Question: Summarize what this figure shows in one sentence.
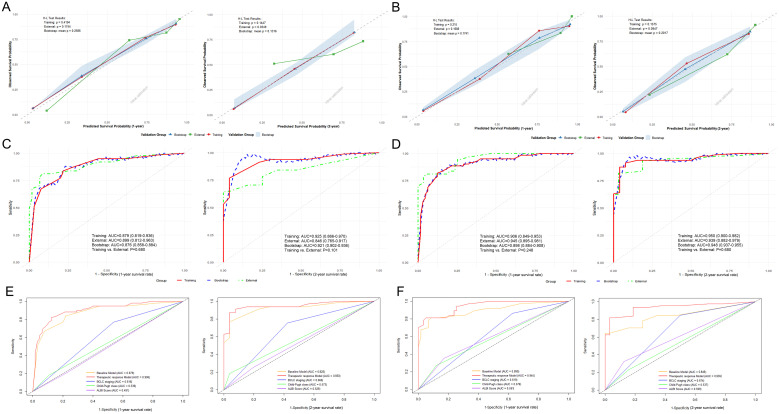
Answer: Validation and assessment of nomogram models. (A) Calibration curves of 1-year and 2-year survival rates for the baseline model; (B) Calibration curves of 1-year and 2-year survival rates for the integrated model; (C) The time-dependent receiver operating characteristic (ROC) curves for 1-year and 2-year survival rates in the baseline model; (D) The time-dependent ROC curves for 1-year and 2-year survival rates in the integrated model; (E) Comparison of the time-dependent ROC curves for 1-year and 2-year survival rates between the dynamic nomogram model and traditional indicators in the training cohort; (F) Comparison of the time-dependent ROC curves for 1-year and 2-year survival rates between the dynamic nomogram model and traditional indicators in the external validation cohort. AUC, area under the curve; BCLC, barcelona clinic liver cancer; ALBI, albumin-bilirubin ratio.